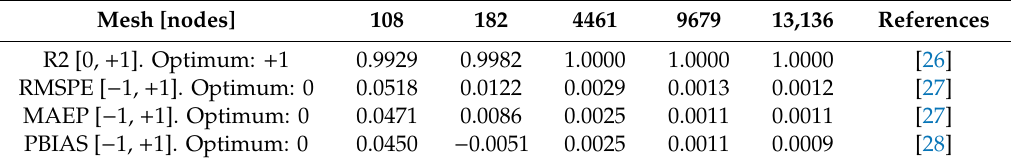
Table 4. Metrics for thermal simulation using [ M λ ]